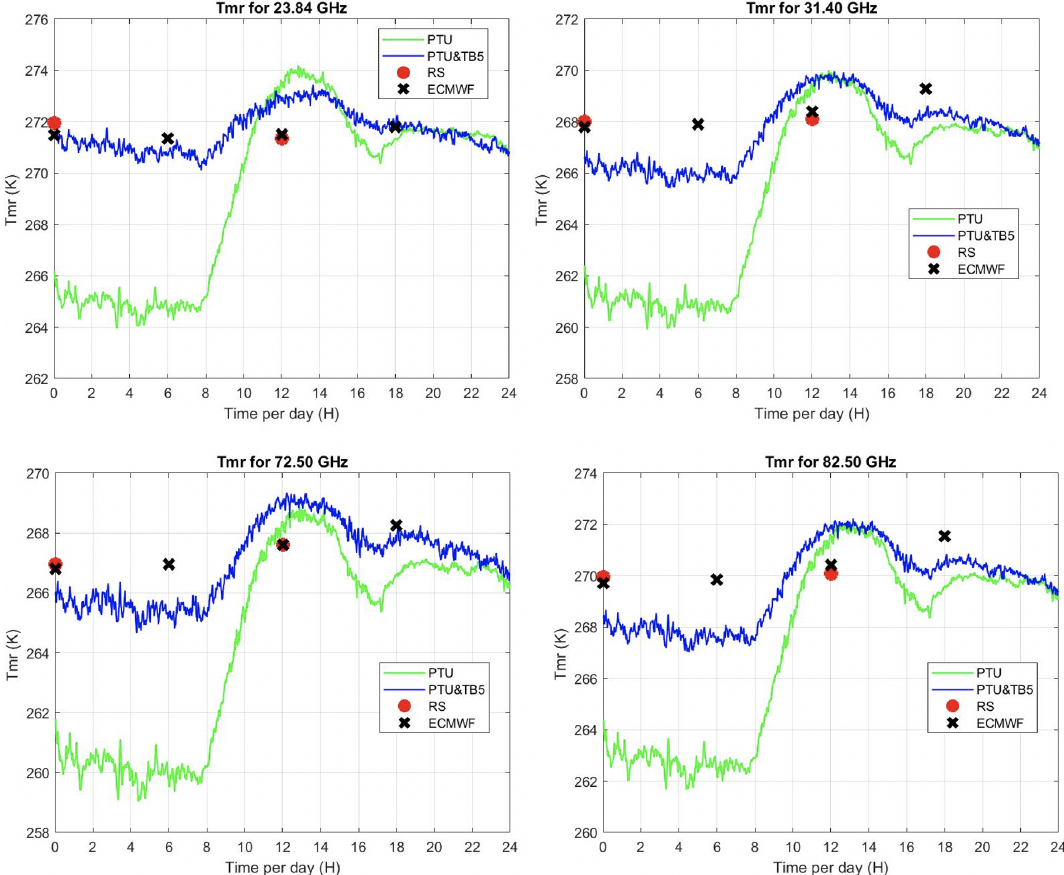
Figure 5. The 24h time series (31 December 2018) of T MR as estimated from surface PTU measurements (green line) and with the additional T B at five V-band channels (blue line). T MR values from twice-daily radiosonde measurements (red dots) and from ECMWF analysis (black crosses) are also reported. Clockwise from top left: 23.84, 31.40, 72.50,